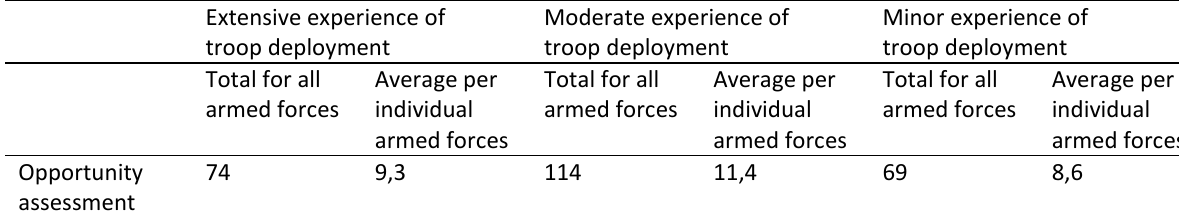
Table 2. Opportunities related to experiences of international deployments.